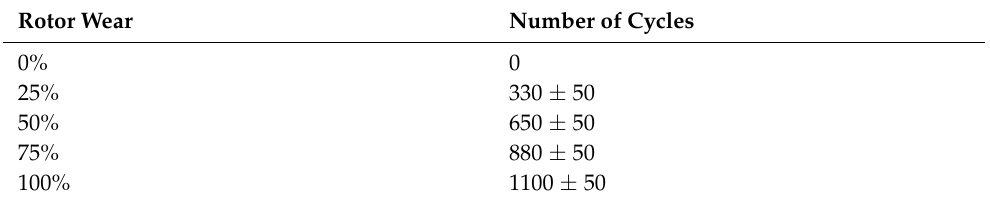
Table 6. Determined rotor wear values depending on the number of cycles performed. Rotor Wear